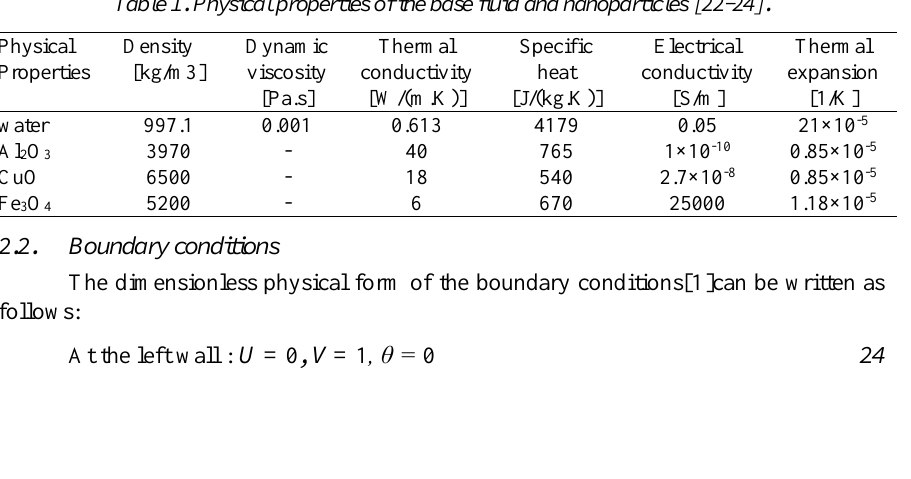
Table 1. Physical properties of the base fluid and nanoparticles